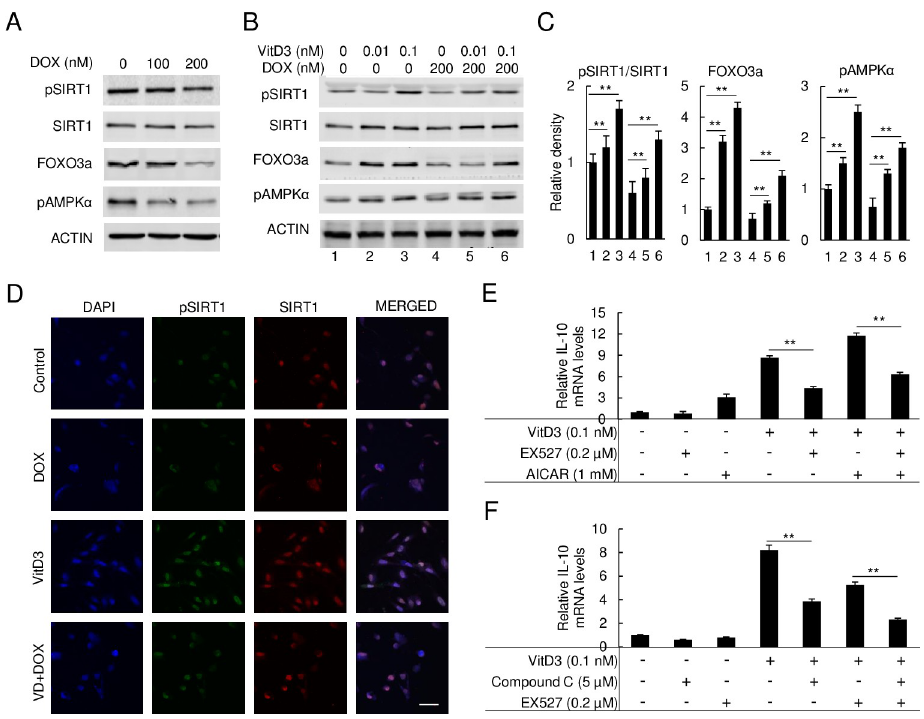
Fig 4. VitD3 directly activates pAMPK α /SIRT1/FOXO3a signal to regulate IL-10 expression. (A) Immunoblot of FOXO3a, pAMPK α , SIRT1, and pSIRT1 expression levels under DOX treatment. (B and C) Immunoblot of FOXO3a, pAMPK α , SIRT1, and pSIRT1 expression levels under DOX and VitD3 co-treatment and the relative density of protein levels was quantified ( �� p < 0.01, n = 3). (D) The immunofluorescence staining of pSIRT1 and SIRT1 on HAECs. pSIRT1 was stained as FITC and SIRT1 as TRITC. DAPI was performed as a nucleus staining as control. Scar bar, 10 μ m. (E and F) qPCR analyzed the relative IL-10 mRNA expression under VitD3, SIRT1 inhibitor, EX527, AMPK α activator, AICAR, and inhibitor, compound C ( �� p < 0.01, n =